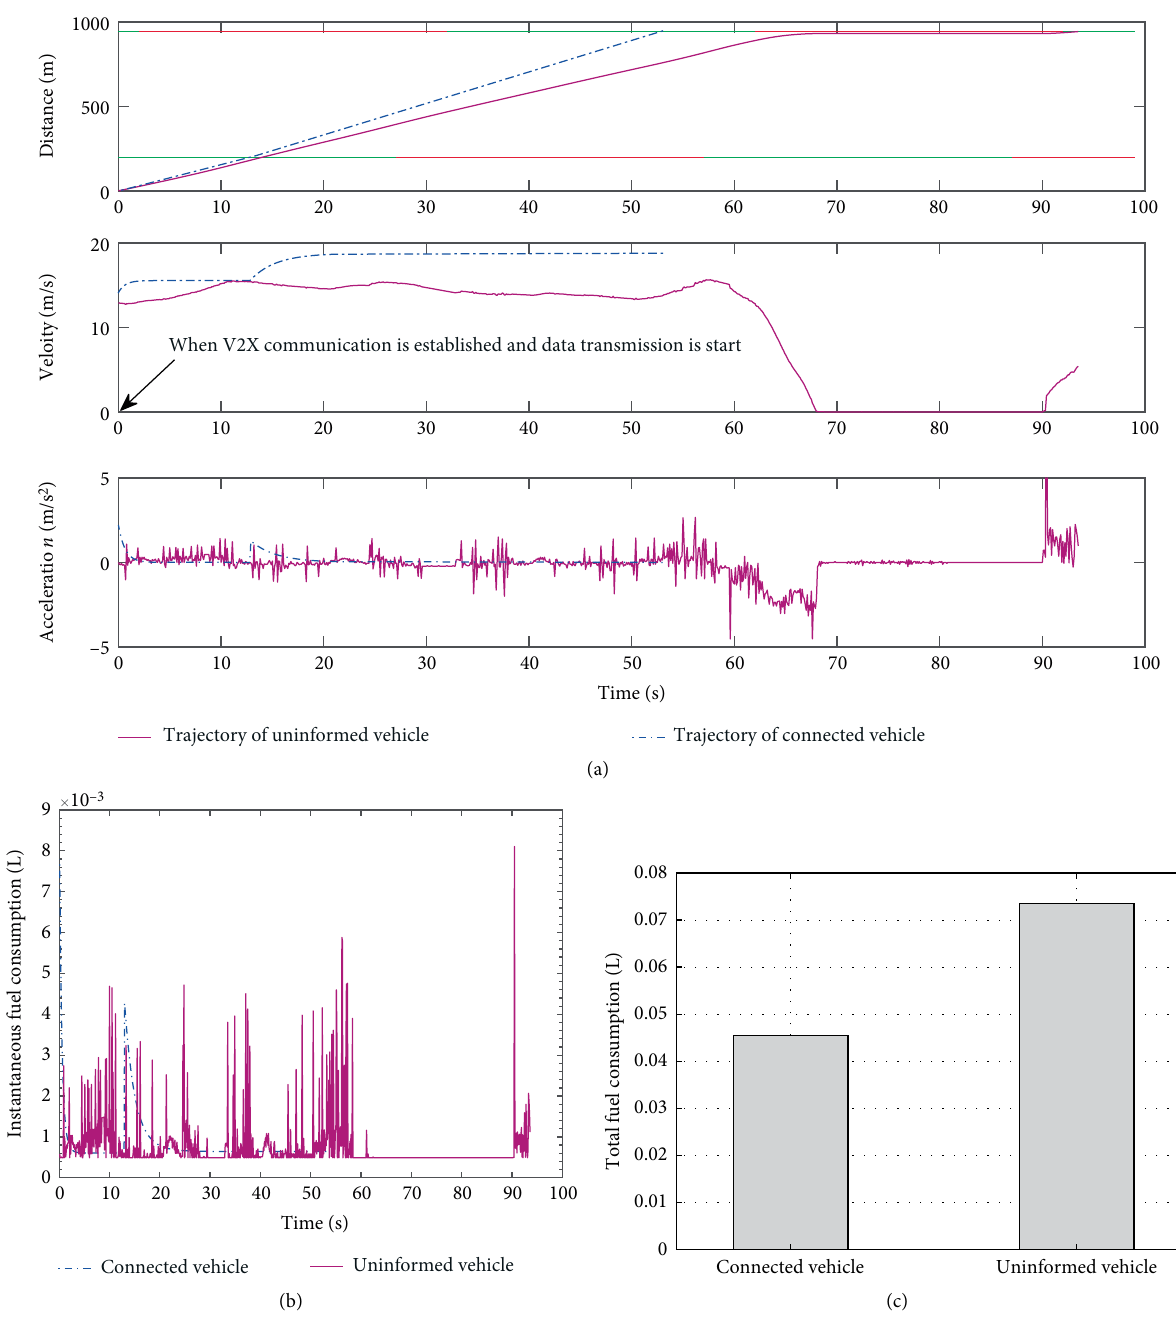
Figure 6: Comparisons between the connected vehicle and the uninformed vehicle. (a) Vehicle trajectories; (b) instantaneous fuel consumption; (c) total fuel